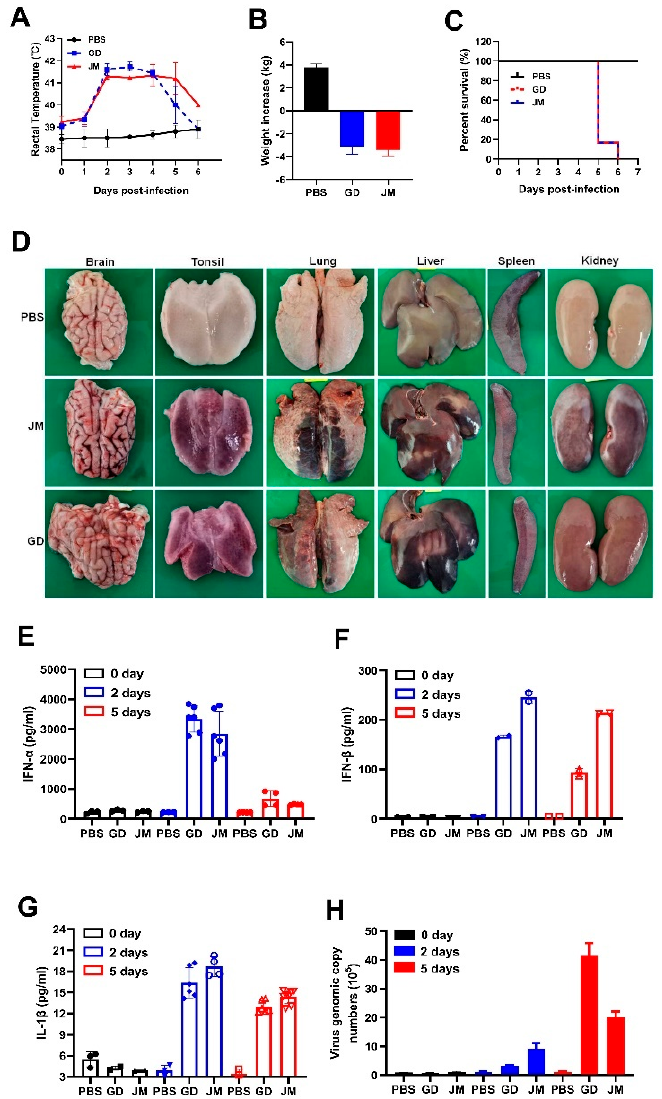
Figure 6. In vivo pathogenicity of PRV-GD and PRV-JM isolates in piglets. ( A ), Rectal temperature of the challenged piglets during the observation. ( B ), The changes of weight of the experimental piglets under the same raised conditions from pre-infection to death. ( C ), Survival rates of piglets infected with PRV-GD or PRV-JM isolates. ( D ), The tissue pathological changes of piglets. ( E – G ), Detection of the protein level of IFN- α , IFN- β and IL-1 β in serum from piglets challenged by PRV-GD or PRV-JM. ( H ), Detection of the PRV genomic copy number in blood after infection for 0 days, 2 days and 5 days.